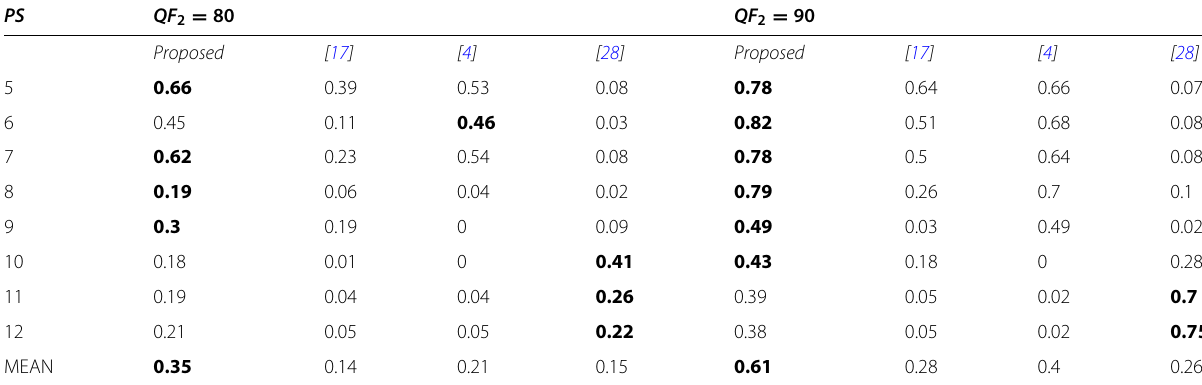
Table 2 Accuracy obtained by proposed approach compared to Bianchi et al. ([17]), Galvan et al. ([4]) and Niu et al. ([28]) employing custom tables for first compression